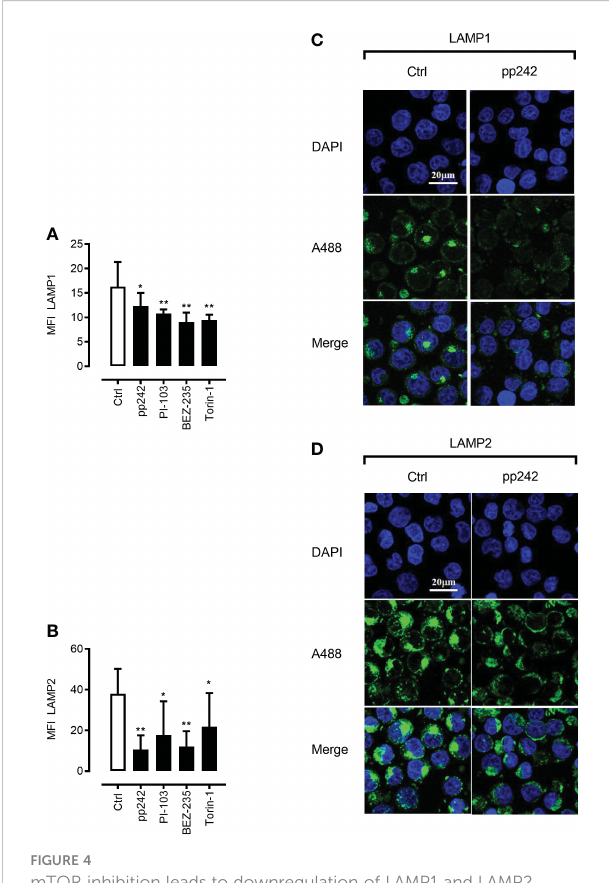
FIGURE 4 mTOR inhibition leads to downregulation of LAMP1 and LAMP2 proteins. Confocal microscopic images after LAMP1 (A, C) and LAMP2 (B, D) staining of K562 cells with and without the treatment with mTOR inhibitor pp242 (5 m M) for 6 h were taken and analyzed using ImageJ software. Images are representative of two independent experiments with more than 3 images taken randomly per condition per experiment. The Green channel is for Alexa fl uor 488 (secondary antibody to LAMP1 and LAMP2 proteins) and the blue is for DAPI (nuclear stain). Data are presented as mean ± S.D. *p < 0.05, **p < 0.001, by One-way ANOVA with Dunnett ’ s multiple comparison test.